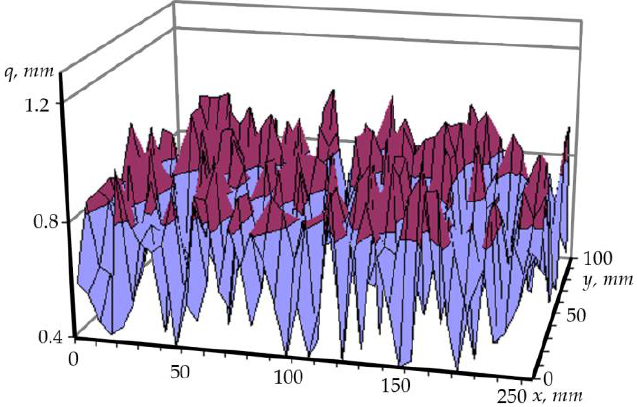
Figure 6. Fragment of a spatial road surface roughness.